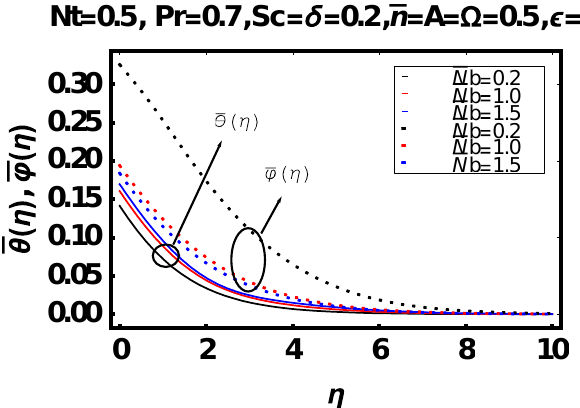
Figure 19. Temperature and concentration profiles for variant N b .